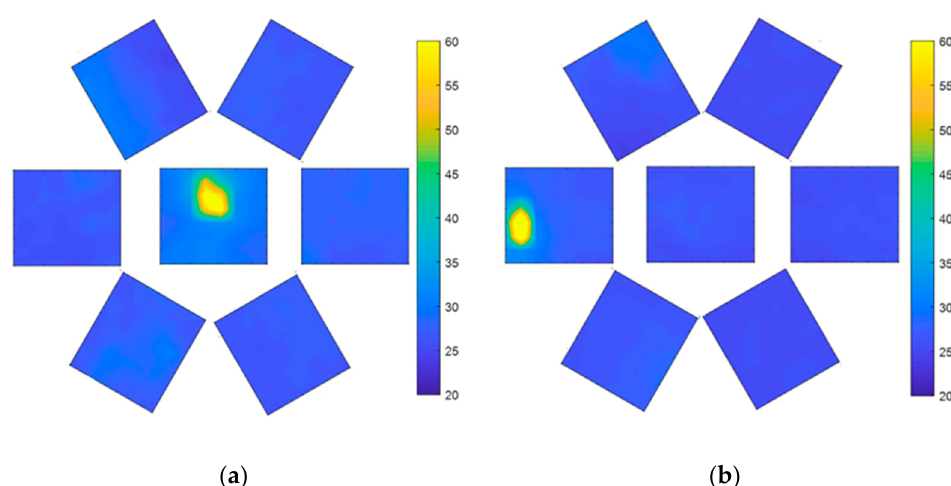
Figure 25. FOV test at 36 kPa. ( a ) Front test image of compound eye. ( b ) Test image of the compound eye rotated to the edge of the FOV.